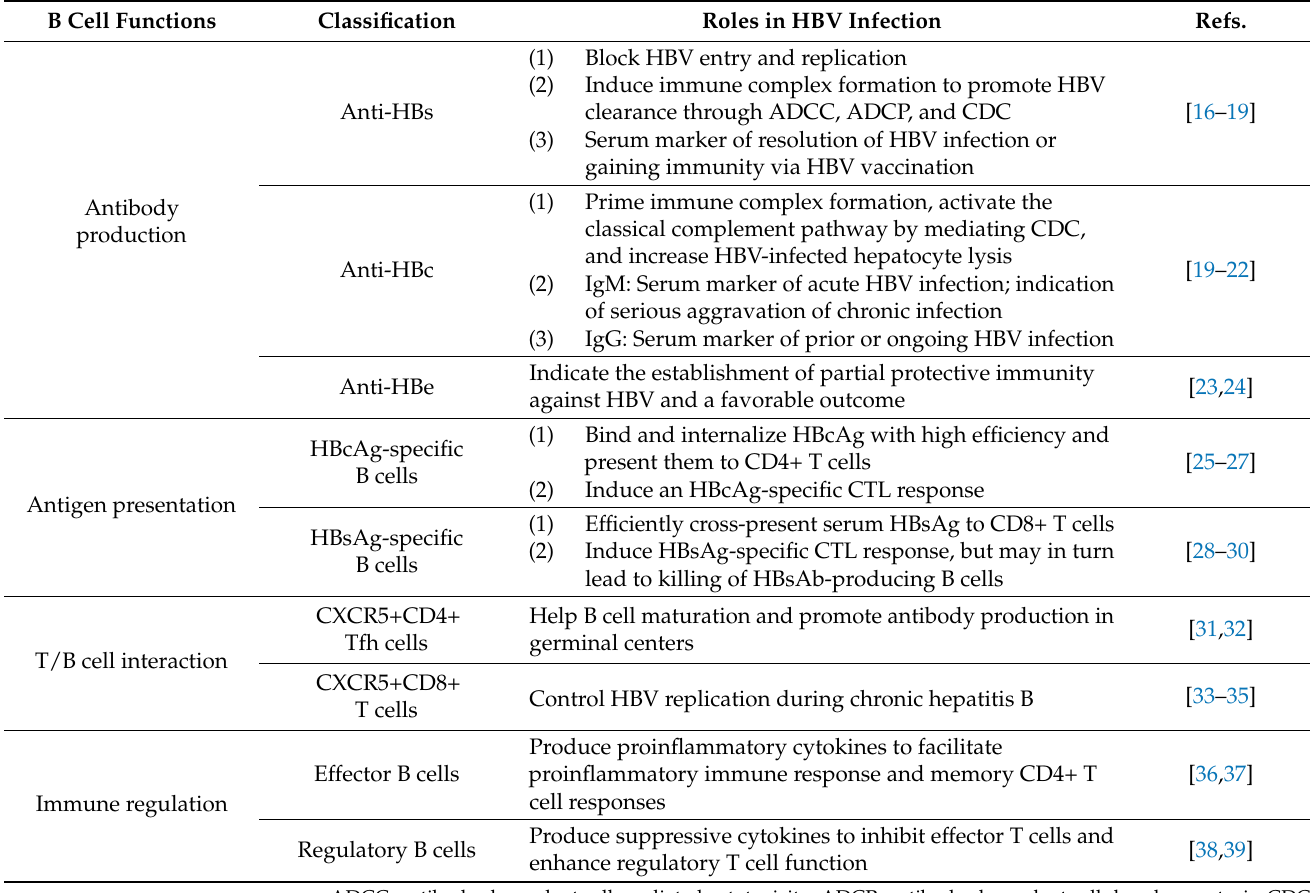
Table 1. Multiple roles of B cells in hepatitis B virus infection. Roles in HBV Infection